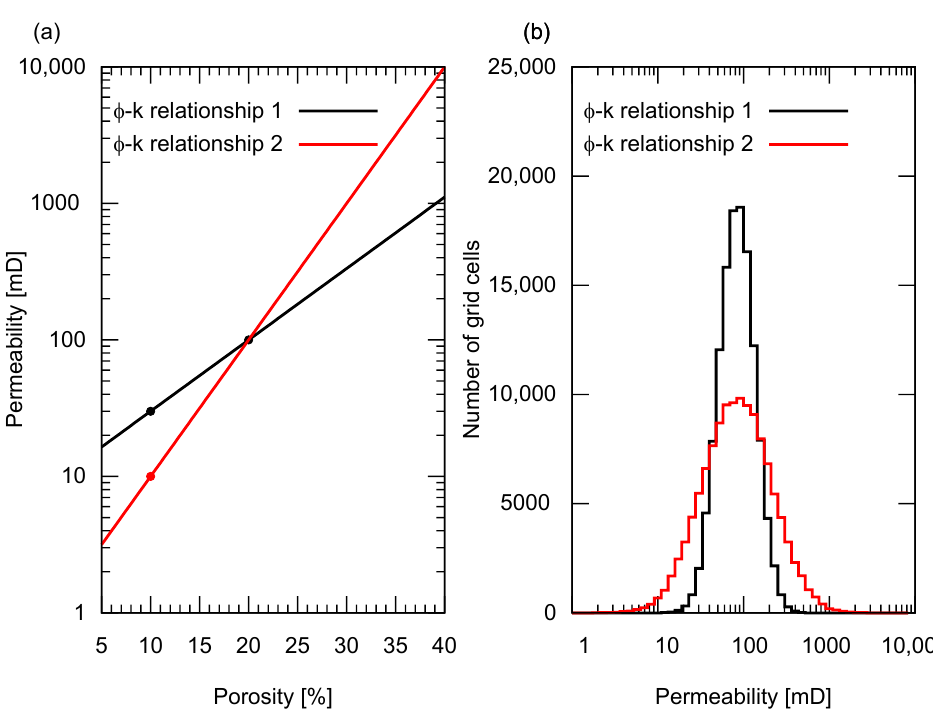
Figure 3. Porosity, φ , and permeability, k , relationships used in the study. ( a ) Exponential type φ – k relationships. Both relationships gave 100 mD permeability for a mean porosity of 20%. The black relationship gave 30 mD for 10% porosity, while the red one gave 10 mD for the same porosity; ( b ) Histogram of the resultant permeability distribution used in the study. The red φ – k relationship resulted in a wider permeability distribution, indicating a greater permeability heterogeneity.